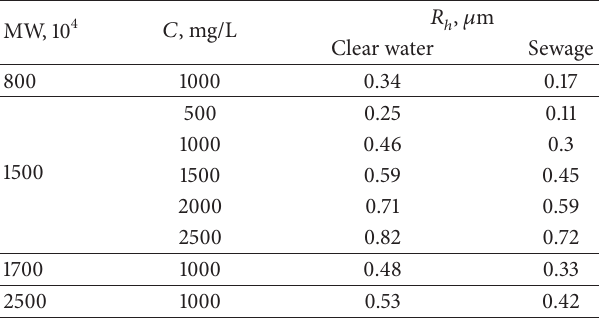
Table 4: The different polymer system hydrodynamic feature